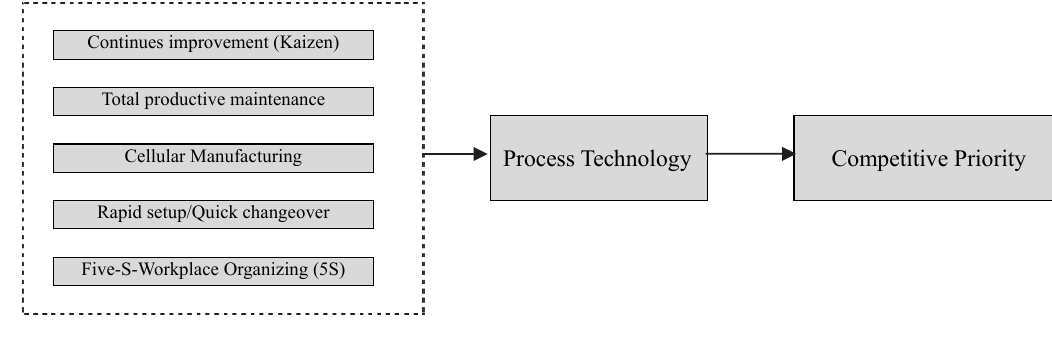
Fig. 1. The Research